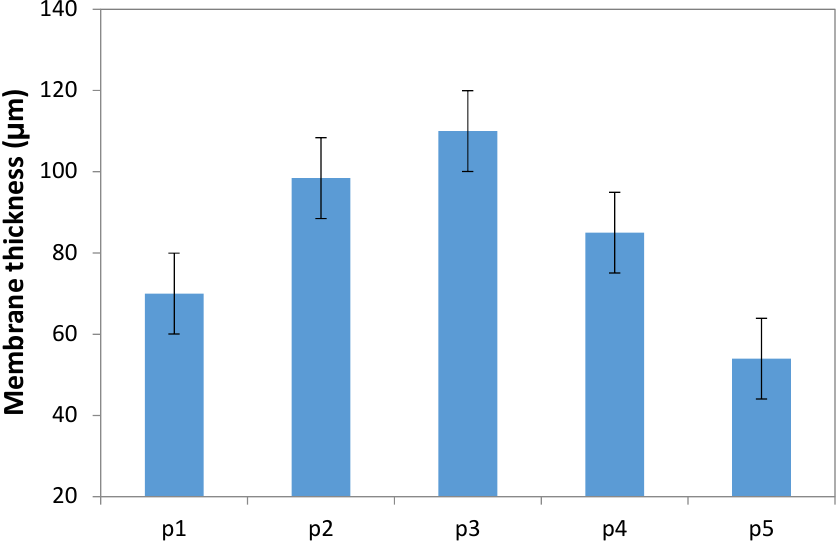
ff ect of PES content on the thickness of the blend Figure 7. Effect of PES content on the thickness of the blend membranes. Figure 7. E Figure 7. Effect of PES content on the thickness of the blend membranes.